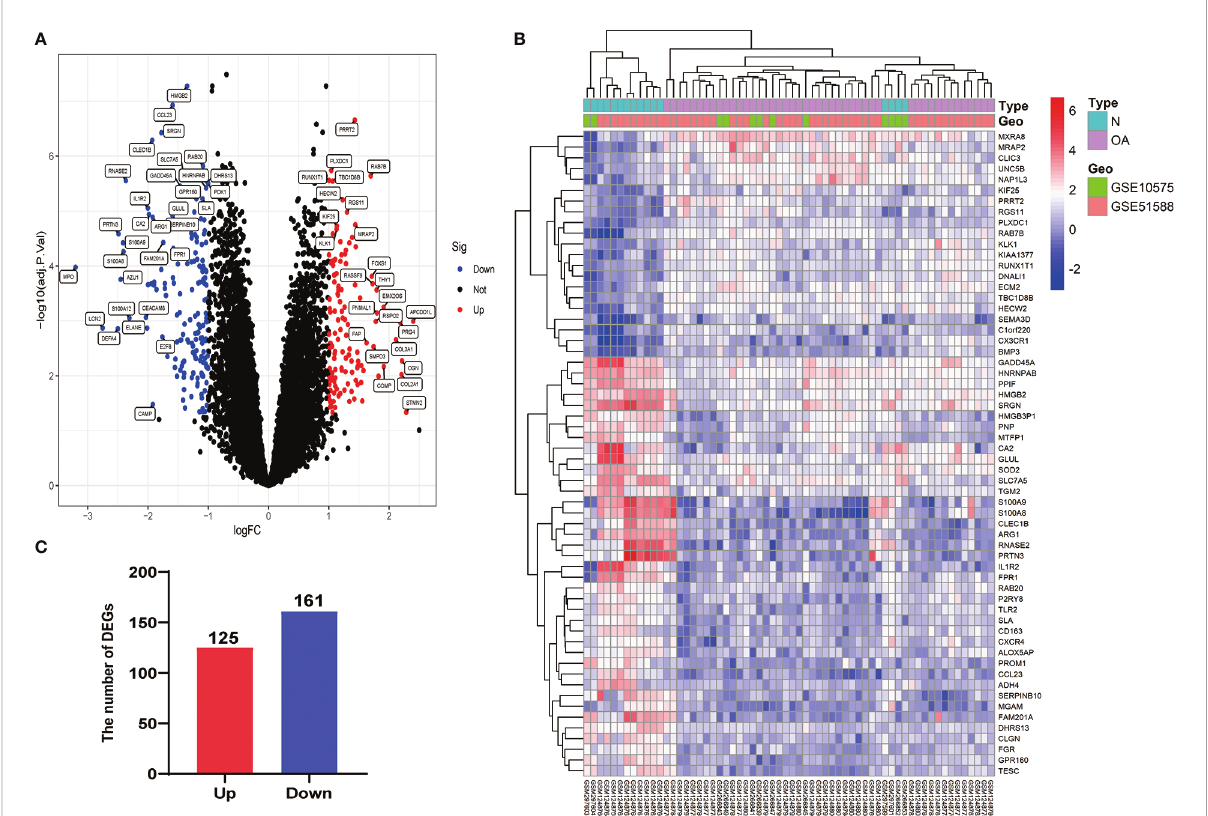
FIGURE 1 Visualization of DEG screening. (A) Volcano plot. Blue represents upregulated genes, red represents downregulated genes, and black represents genes with no difference. (B) Heatmap of the fi rst 60 DEGs between different cohorts (GSE10575 and GSE51588) and sample types (Normal and OA). (C) Histogram of